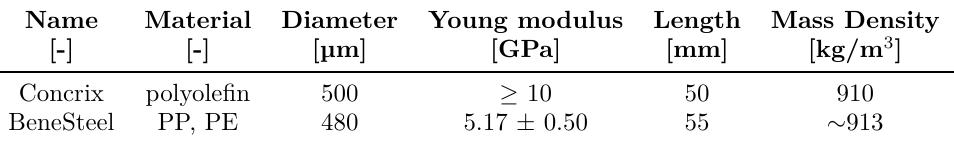
Table 1. Summary of basic fiber parameters.